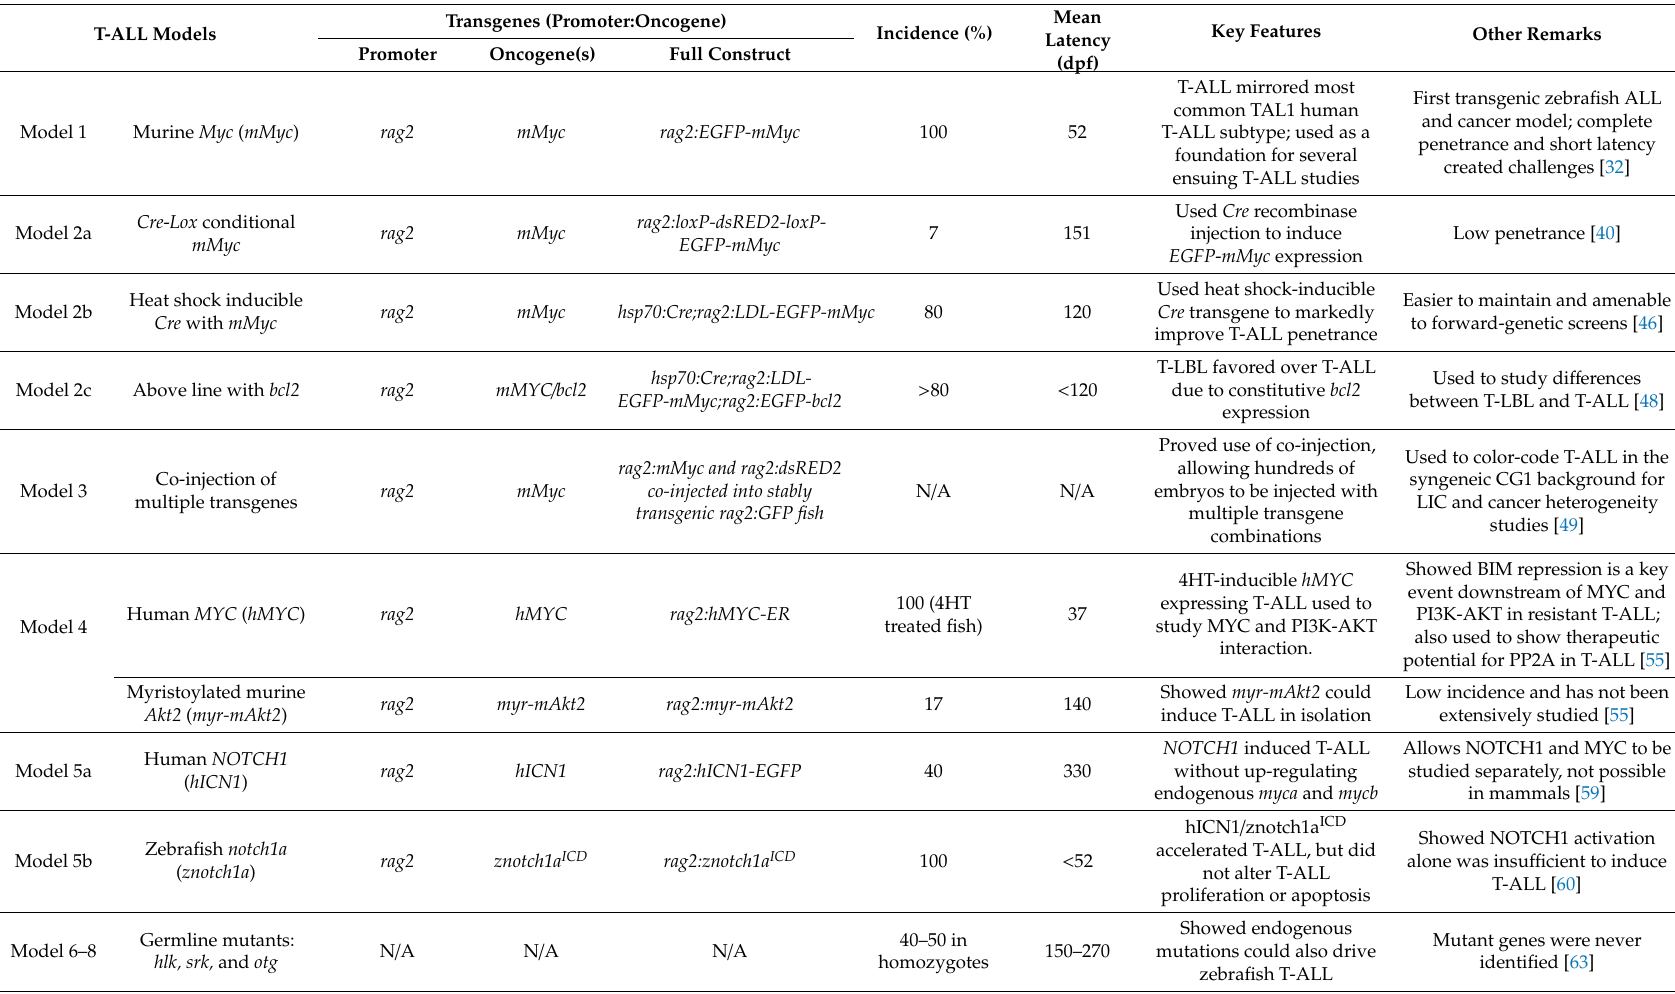
Table 1. Summary of zebrafish acute lymphoblastic leukemia (ALL)